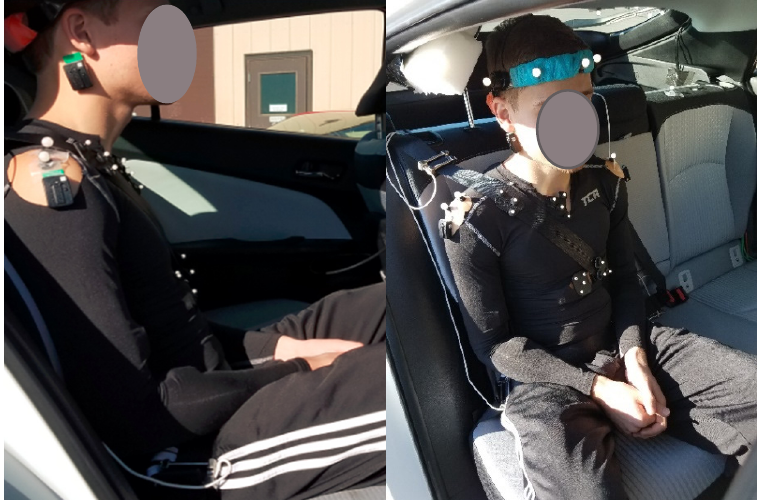
Figure 2. Subject instrumentation: photo-reflective markers placed on the head, the trunk, and the seat belt (left), and wireless EMG (electromyography) sensors visible on the neck and the right deltoid (right).